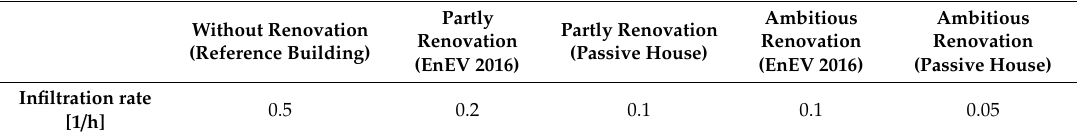
Table 2. Input parameters for infiltration rate.